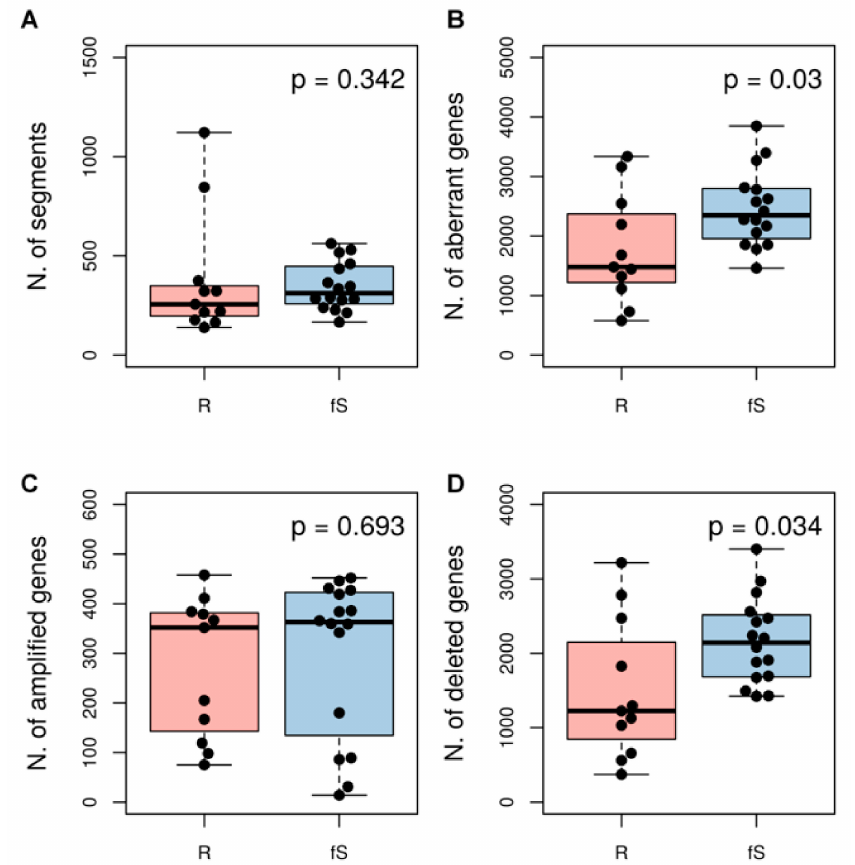
Figure 3. Association between genomic instability and sensitivity class in TCGA-OV27 dataset. As measure of genomic instability for each sample we considered: ( A ) the number of segments that represents the number of regions with di ff erent copy number levels within a genome; ( B ) the total number of amplified or deleted genes; the total number of amplified genes only ( C ) or deleted genes only ( D ). P -values are according to Wilcoxon rank-sum